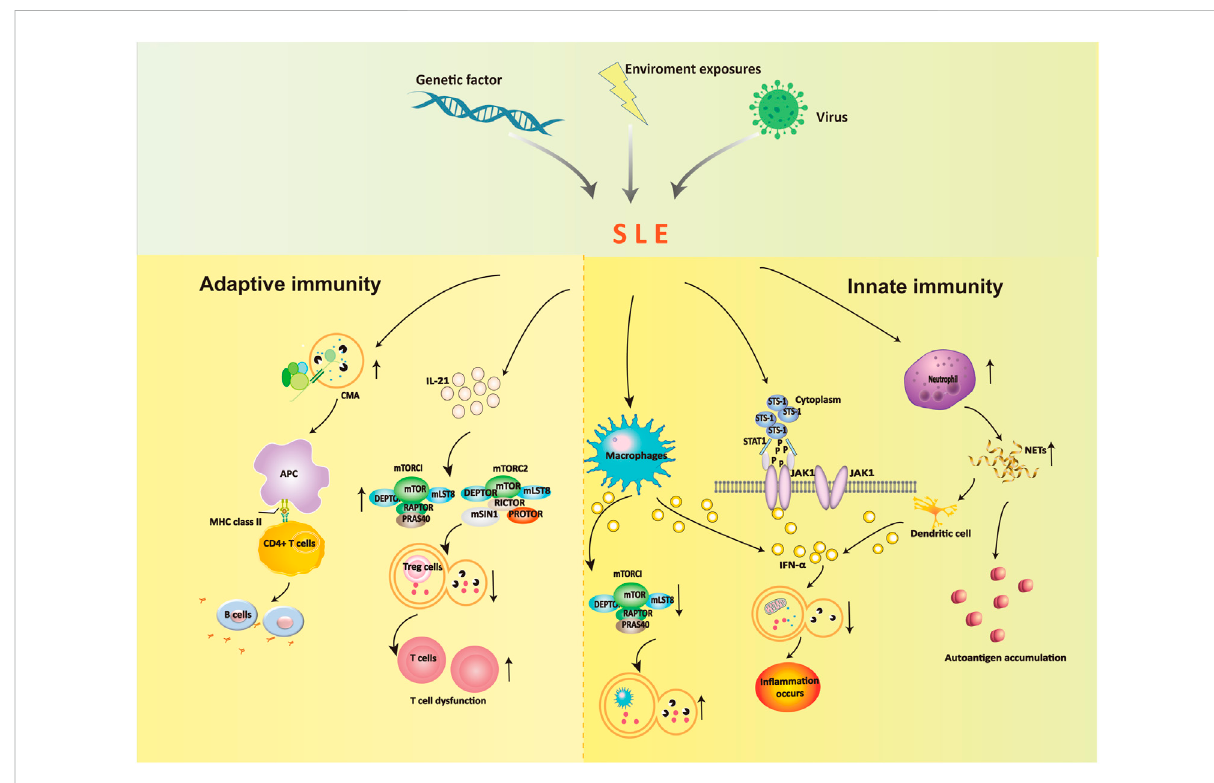
FIGURE 2 The role of autophagy in the dysregulation of innate immunity and adaptive